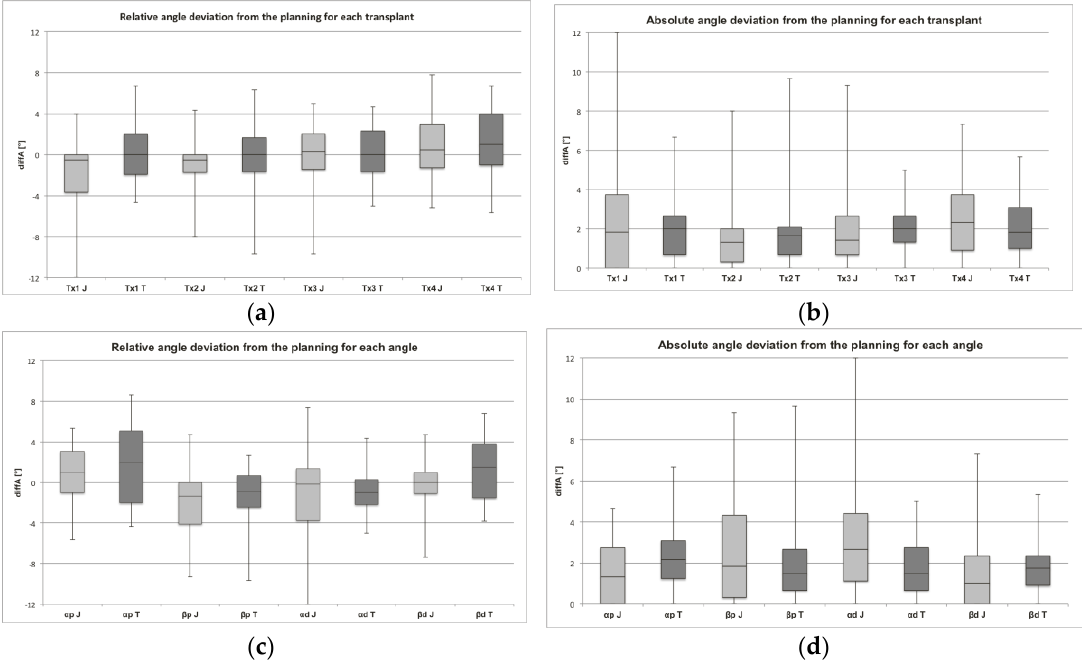
Figure 7. Assessed angle deviations. In ( a ) and ( b ), the relative and absolute deviations from the original planning parameters are shown for each transplant (Tx1 – Tx4) separately for both methods (J: MUC-Jig, T: template). In ( c ) and ( d ), the relative and absolute deviations from the original planning parameters are shown for each measured angle (α p , β p , α d , β d ) separately for both methods (J: MUC-Jig, T: template).